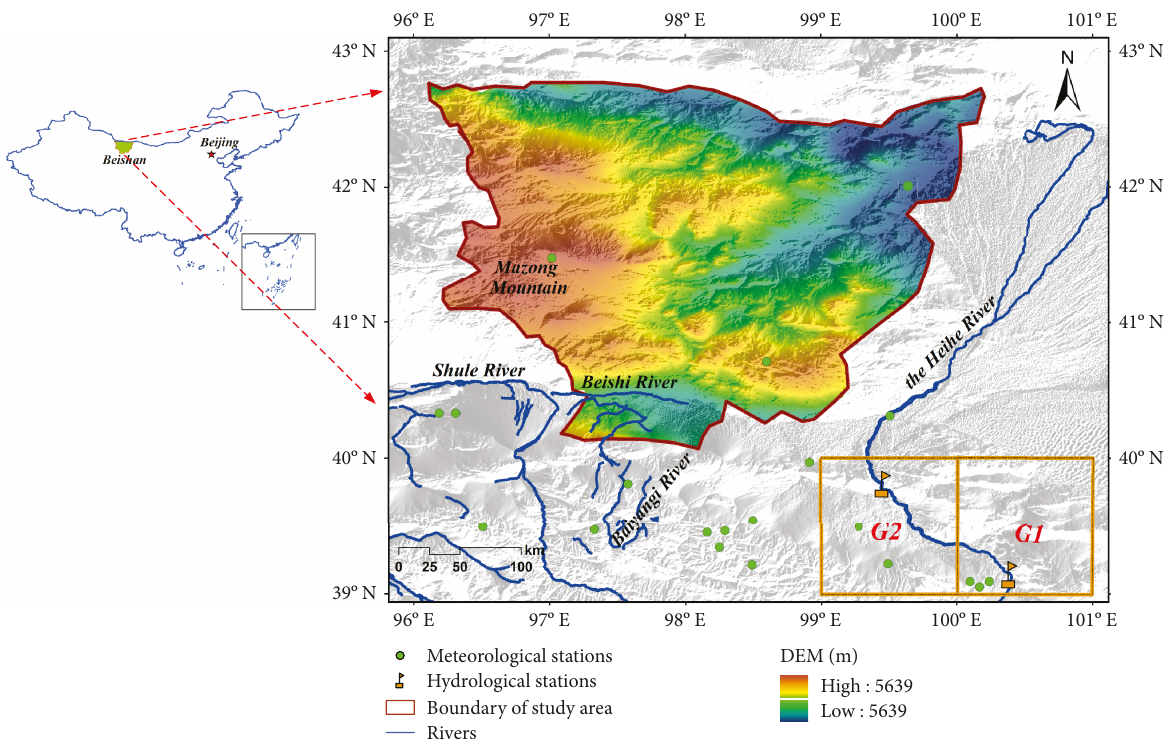
Figure 1: Location and a digital elevation of the Beishan area and distribution of meteorological and hydrological stations across the